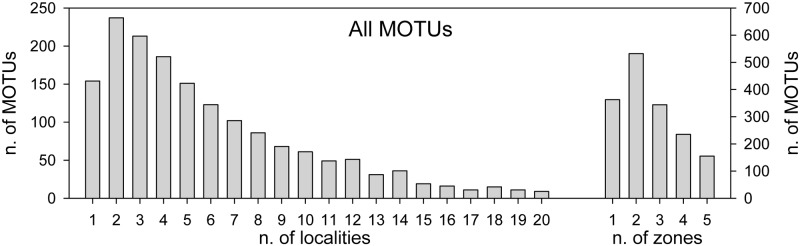
Distributional span of the MOTUs.The graph represents the frequency histograms of the number of MOTUs present in 1 to 20 samples or in 1 to 5 zones (right axis).